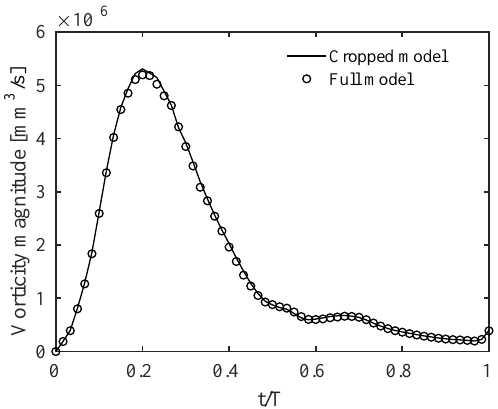
Figure A3. Time evolution during the cardiac cycle of the vorticity magnitude integrated over the computational domain for the cropped model and the corresponding portion of the full model. T is the period of the cardiac